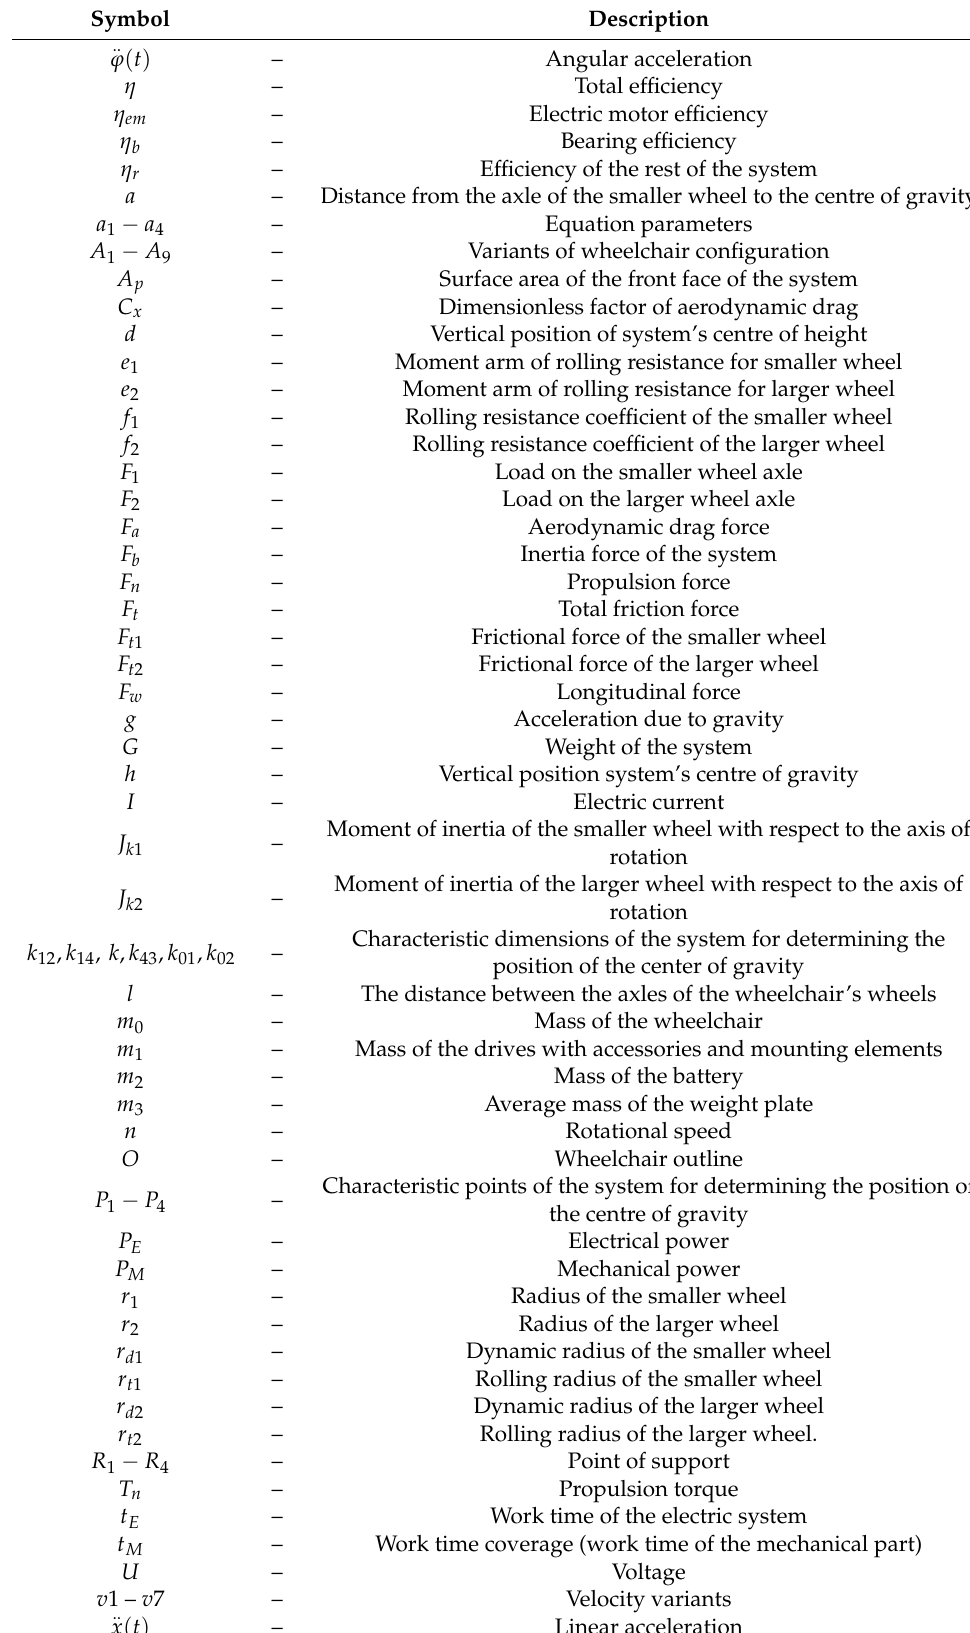
Table A1. Cont. Symbol